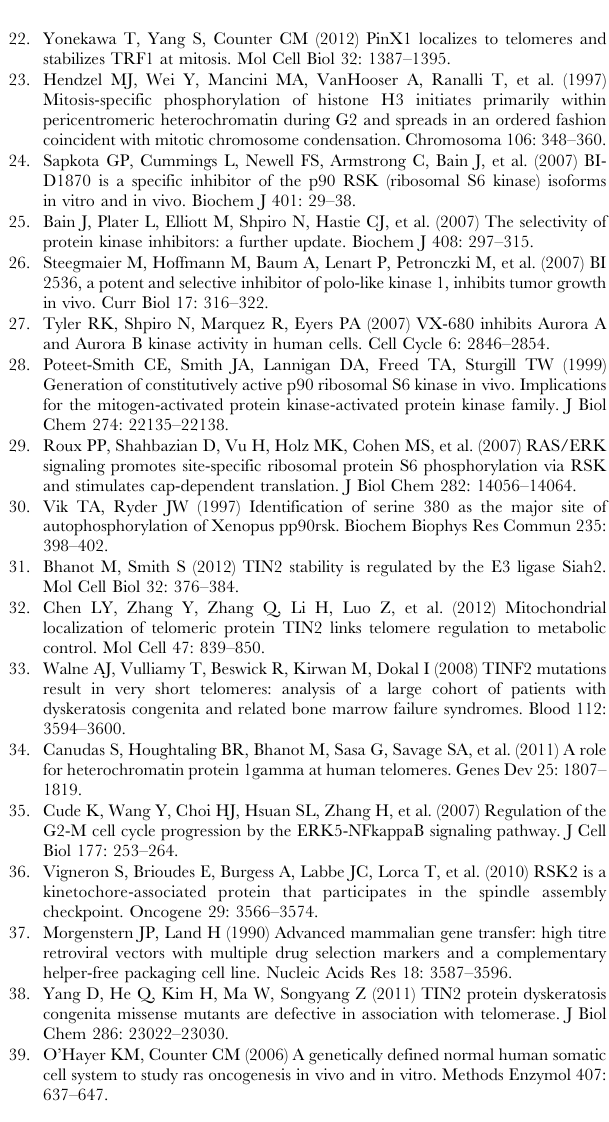
quantified by imageJ, normalized to that of tubulin, and plotted against time. Representative of two experiments. Figure S6 Co-localization analysis of wild-type and phosphorylation mutant versions of TIN2 with Mito- Tracker Red. Confocal microscope imaging of HeLa cells transiently transfected with pEGFP-N1-TIN2 in the WT, 295A, 330A, or AA configurations. DNA was visualized by staining with DAPI, ectopic TIN2 proteins were visualized by virtue of GFP, mitochondria were visualized by staining with MitoTracker Red, and co-localization between TIN2 and mitochondria were visualized by overlaying the latter two images. Each panel represents one of six cells imaged. Figure S7 Analysis of telomere-dysfunction induced foci in TIN2 knockdown cells rescued with wild-type or phosphorylation mutant versions of TIN2. HeLa cells stably infected with pBabe-puro encoding no transgene (vector) or Flag-TIN2 in the wild-type (WT) or AA configuration